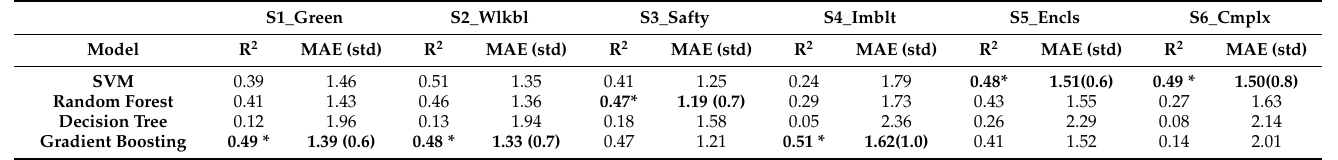
Table 4. Performance of machine learning